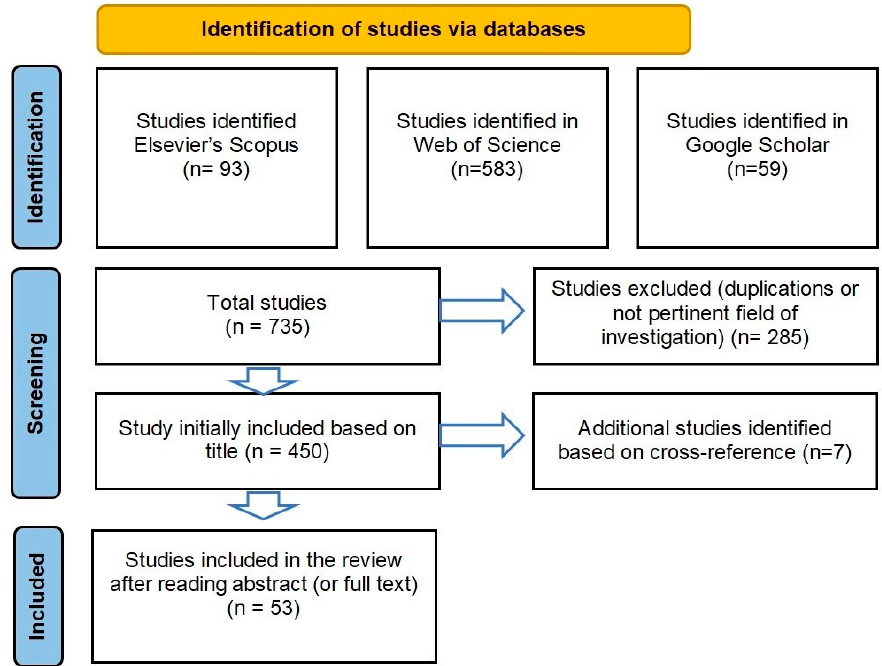
Figure 1. Flow diagram of the reporting items from PRISMA. Source: adapted for PRISMA.